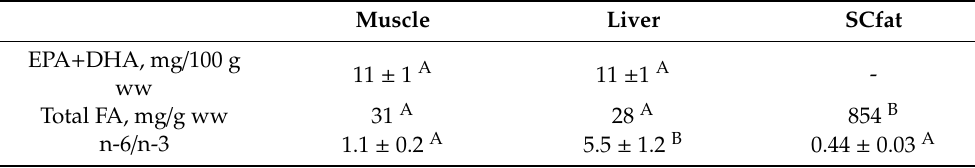
Table 4. Content of EPA + DHA and total fatty acids (mg / 100g and mg / g of wet weight, respectively) and the ratio of total omega-6 and omega-3 PUFAs in the muscle, liver, and subcutaneous adipose tissue of Yakutian horses. Means in lines labeled with the same letters are not significantly di ff erent at p < 0.05 after Tukey’s HSD post hoc test (normal distribution, standard errors are given) or Kruskal–Wallis test with multiple comparisons of mean ranks (non-normal distribution standard errors are